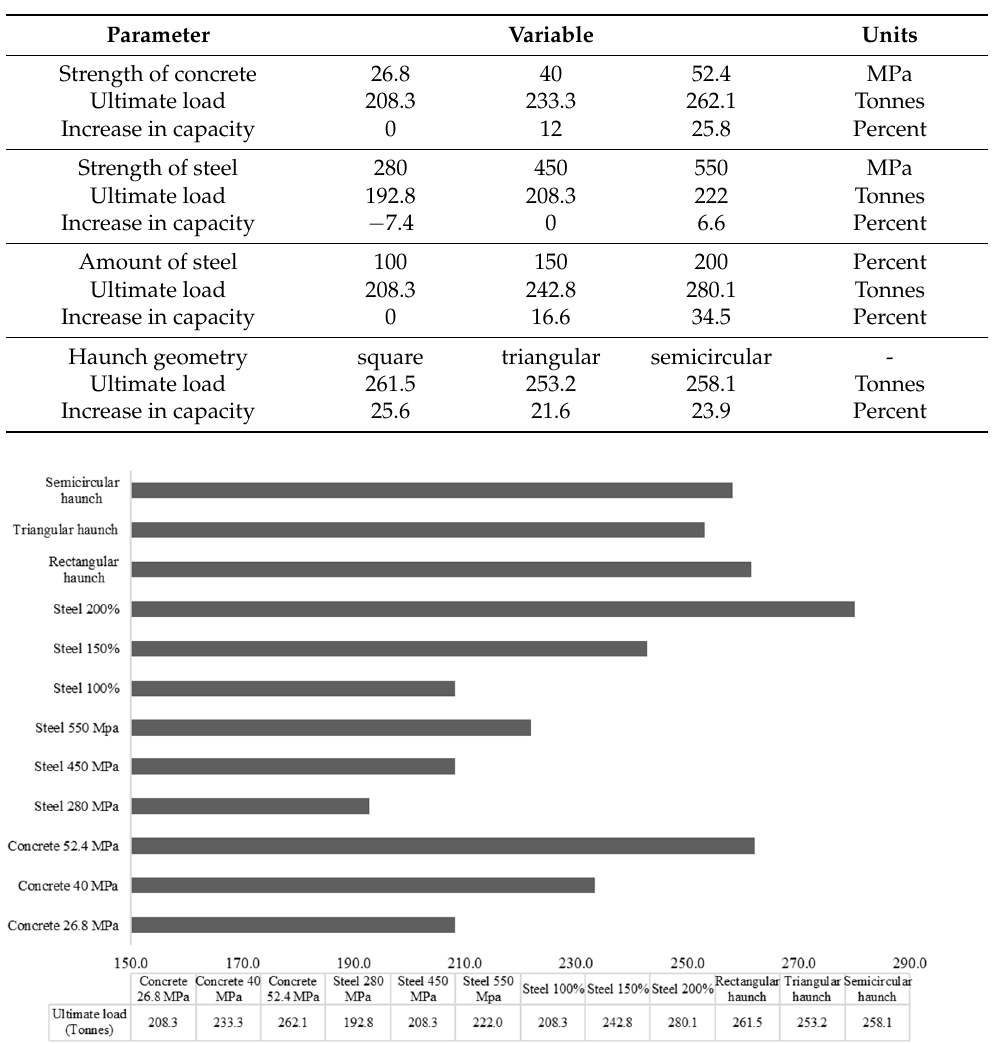
Figure 8. Summary of results of the parametric analysis.